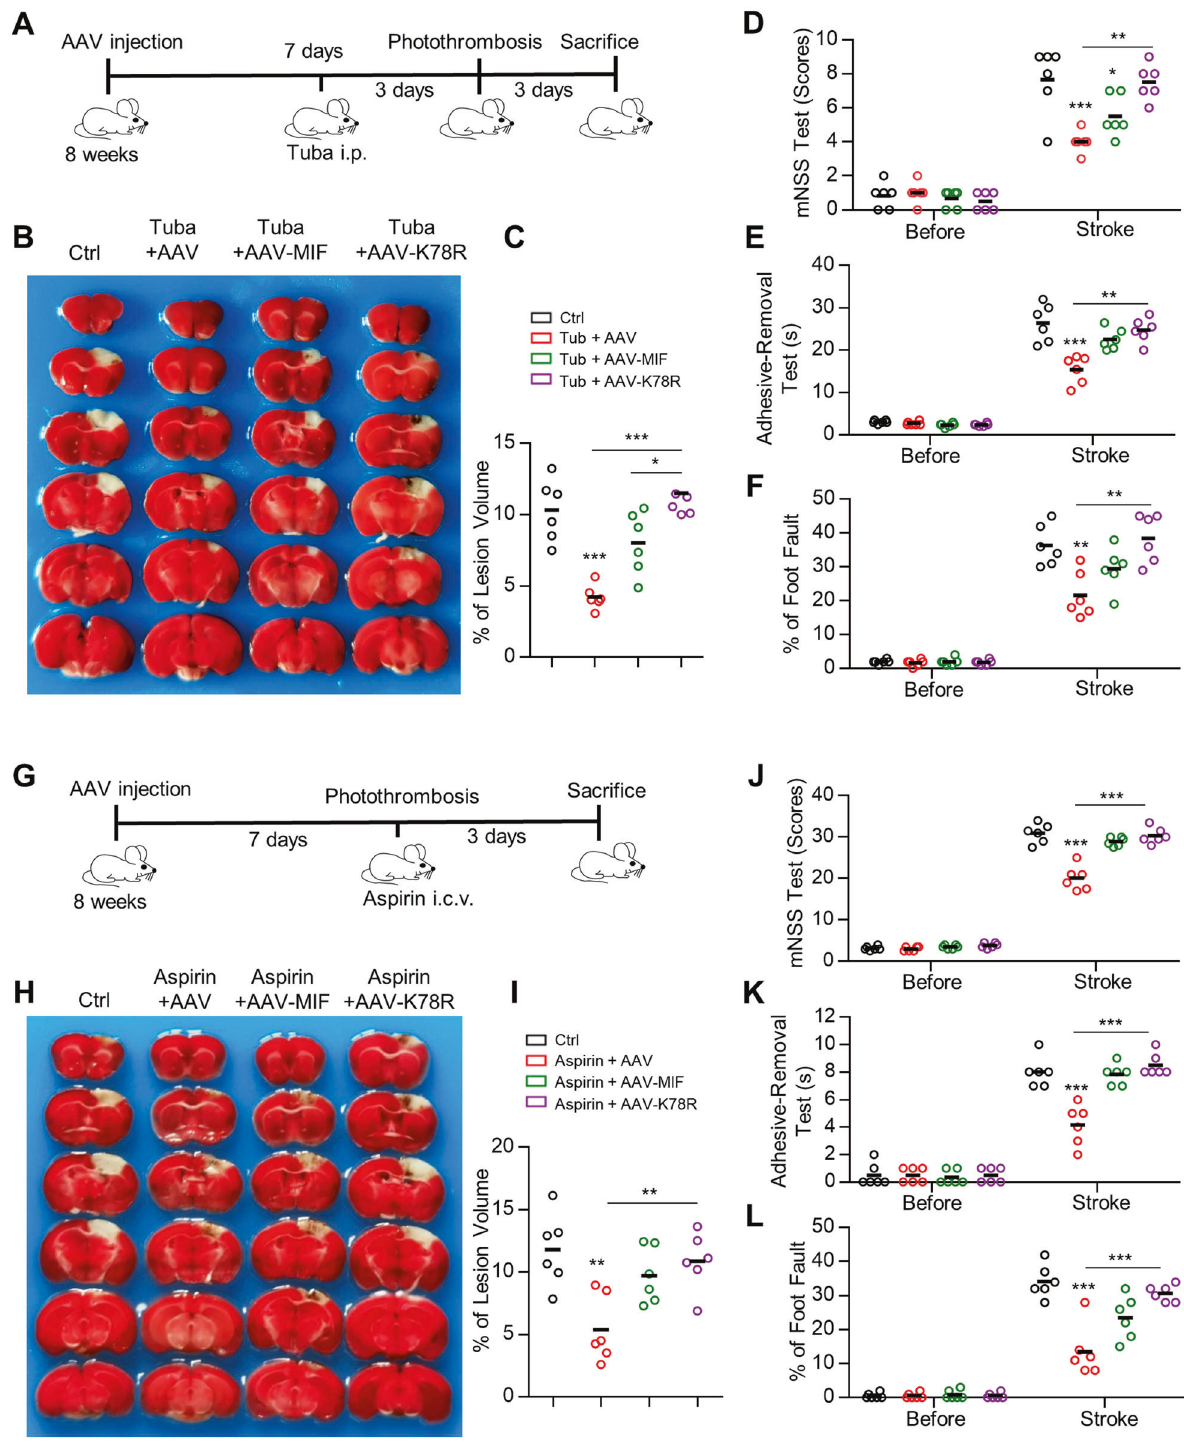
Fig. 5 HDAC6 inhibitor and aspirin protect neuronal death through increasing MIF acetylation after ischemia. A Diagram of the experimental procedure. B HDAC6 inhibitor protects against ischemia-induced neuronal death through MIF acetylation. Mice were infected with either AAV-MIF-2A-mCherry or AAV-K78R-2A-mCherry and administered tubastatin A every day for 3 days. Ischemia was then induced and the infarct volume was analyzed by TTC staining in brain sections. C Quanti fi cation analysis of the lesion volume is shown in ( B ). Data shown were independent points and mean; one-way ANOVA, n = 6; * p < 0.05; *** p < 0.001. D – F Neurological de fi cits were evaluated by the mNSS test ( D ), adhesive-removal test ( E ), and foot fault assays ( F ). Data shown were independent points and mean; two-way ANOVA; n = 6; * p < 0.05; ** p < 0.01; *** p < 0.001. G Diagram of the experimental procedure. H Aspirin protects against ischemia-induced neuronal death through MIF acetylation. Mice were infected with AAVs and administered aspirin. Ischemia was induced and infarct volume was analyzed by TTC staining in brain sections. I Quanti fi cation analysis of the lesion volume is shown in ( H ). Data shown were independent points and mean; one-way ANOVA, n = 6; ** p < 0.01. J – L Neurological de fi cits were evaluated by the mNSS test ( J ), adhesive-removal test ( K ), and foot fault assays ( L ). Data shown were independent points and mean; two-way ANOVA; n = 6; *** p < 0.001. Cell Death and Disease (2022)